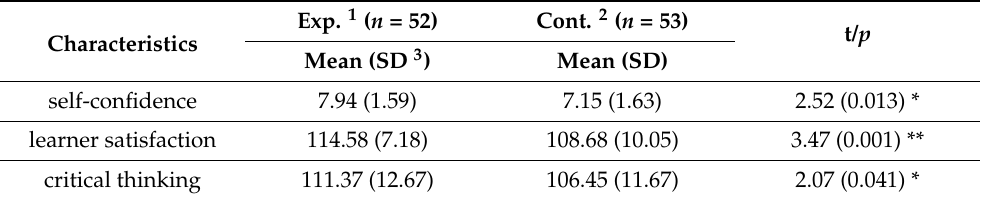
Table 5. Comparison of self-confidence, learner satisfaction, critical thinking between the experimen- tal and control